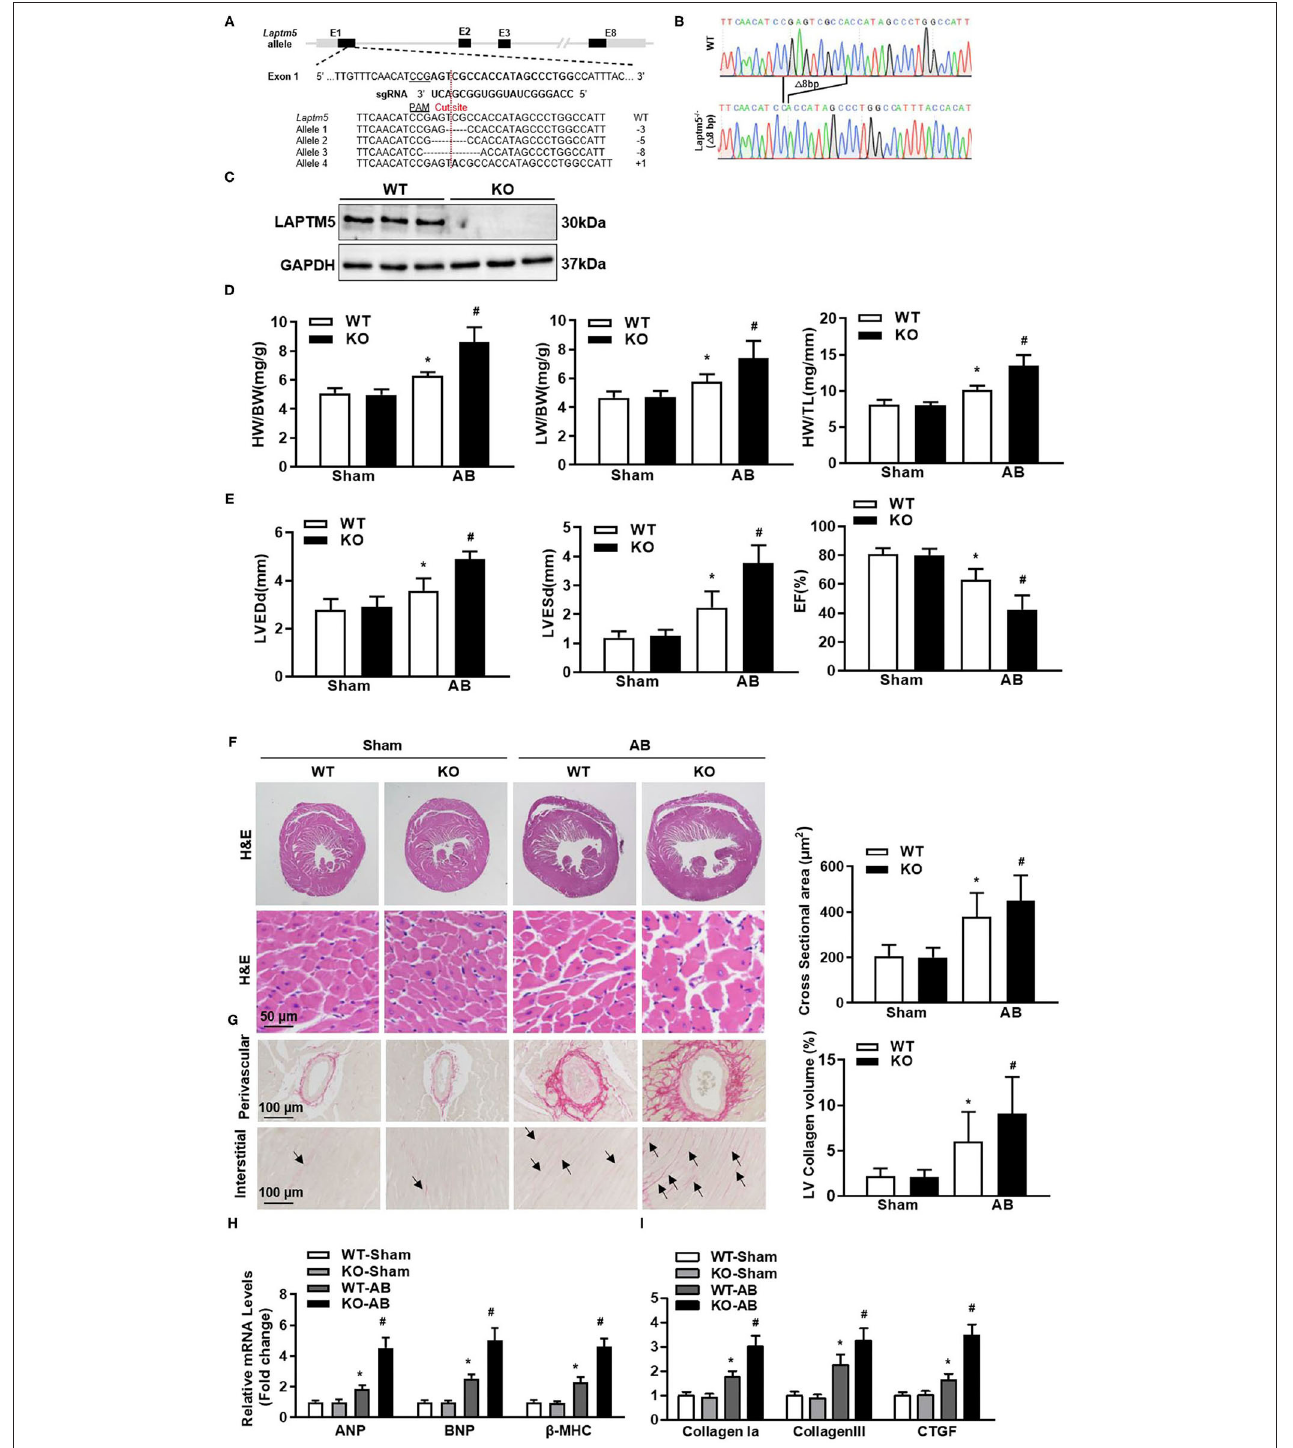
FIGURE 3 | Ablation of LAPTM5 exacerbates pressure overload-induced remodeling. (A) Strategy of generating cardiac-specific conditional LAPTM5-KO mice. (B) Sanger sequencing results of heart tissue in WT and LAPTM5-KO mice. (C) Protein level of LAPTM5 in heart tissue in WT and LAPTM5-KO mice ( n = 3). (D) Heart weight (HW) to body weight (BW) ratio, HW to tibia length (TL) ratio, lung weight (LW) to BW ratio in the indicated groups ( n = 10). (E) Echocardiography results in each group ( n = 10). LVEDd, left ventricular end diastolic diameter; LVESd, left ventricular end systolic diameter; EF, ejection fraction. (F) Representative image of H&E staining and the quantitative results ( n = 6). (G) Representative image of PSR staining and the quantitative result ( n = 6). (H,I) The mRNA levels of hypertrophic and fibrosis markers were detected by real-time PCR ( n = 6) (* P < 0.05 vs. WT-Sham, # P < 0.05 vs. WT-AB).